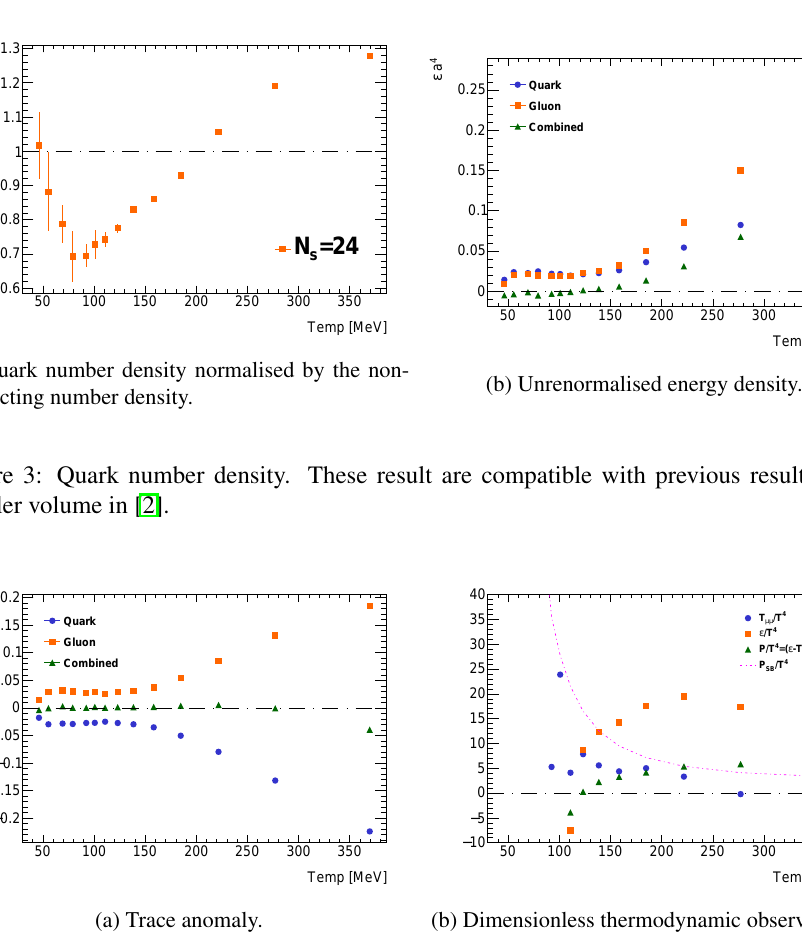
Figure 4: Thermodynamic